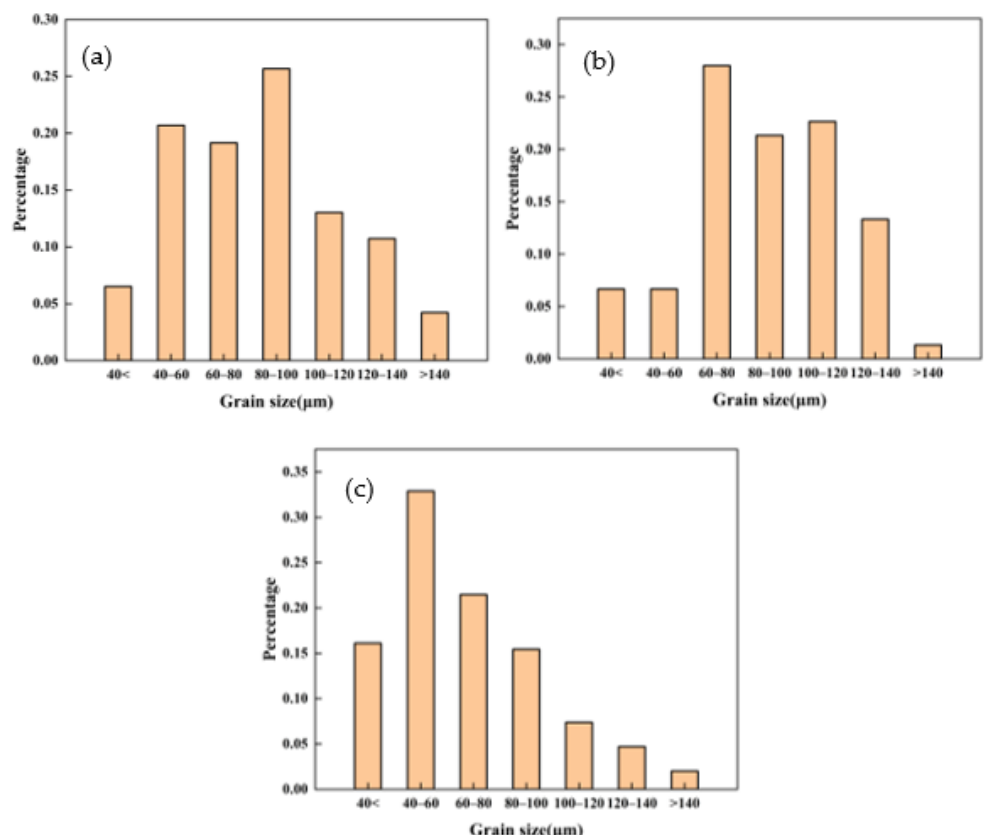
Figure 5. The grain size distribution statistics chart of the Al-Zn-Mg-Cu-based alloy annealed under ( a ) atmospheric pressure, ( b ) 2 GPa, and ( c ) 3 GPa,